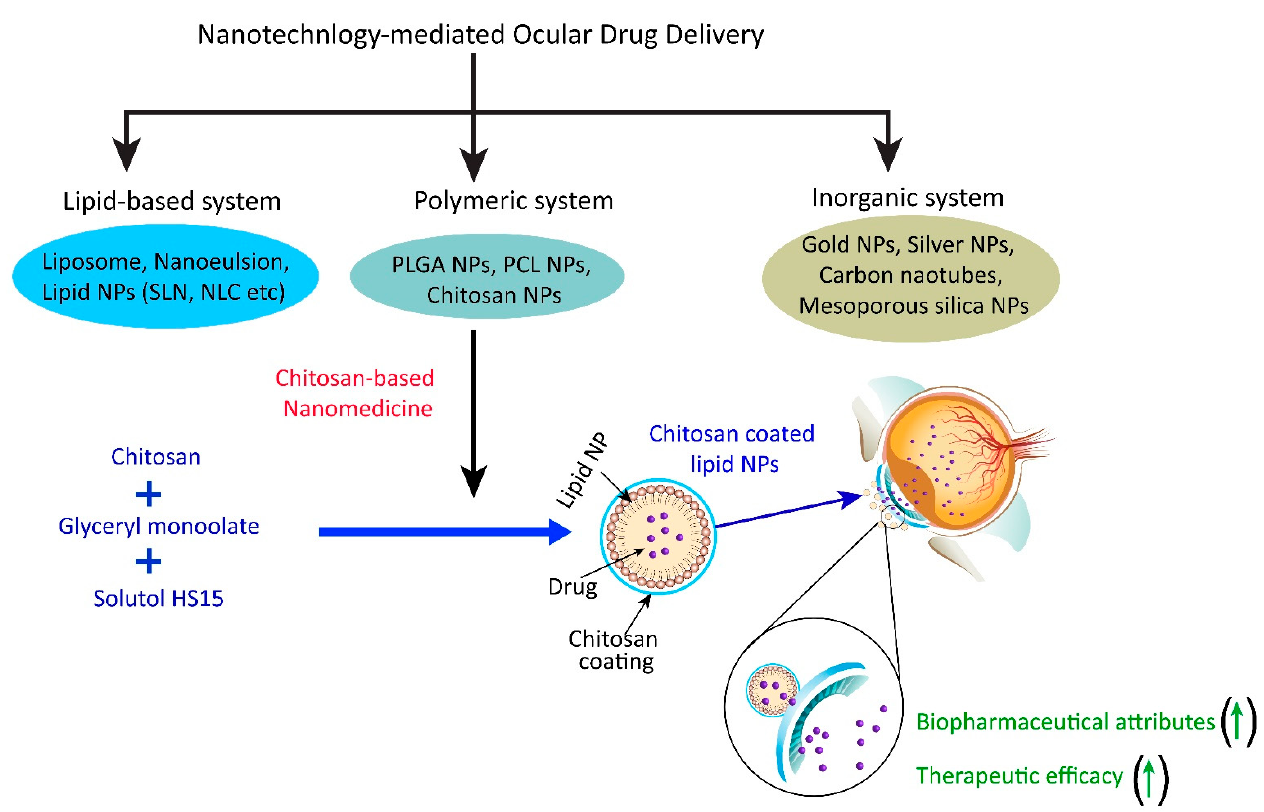
Figure 2. Nanotechnology-mediated drug delivery approach particularly regarding a chitosan-based nanomedicine employed to improve the biopharmaceutical attributes and therapeutic efficacy of a loaded drug in glaucoma. ( ↑ ) indicates improvement/increase. Table 1. Comparative advantages of nanotechnology-mediated ocular drug delivery in respect to conventional ocular drug delivery.